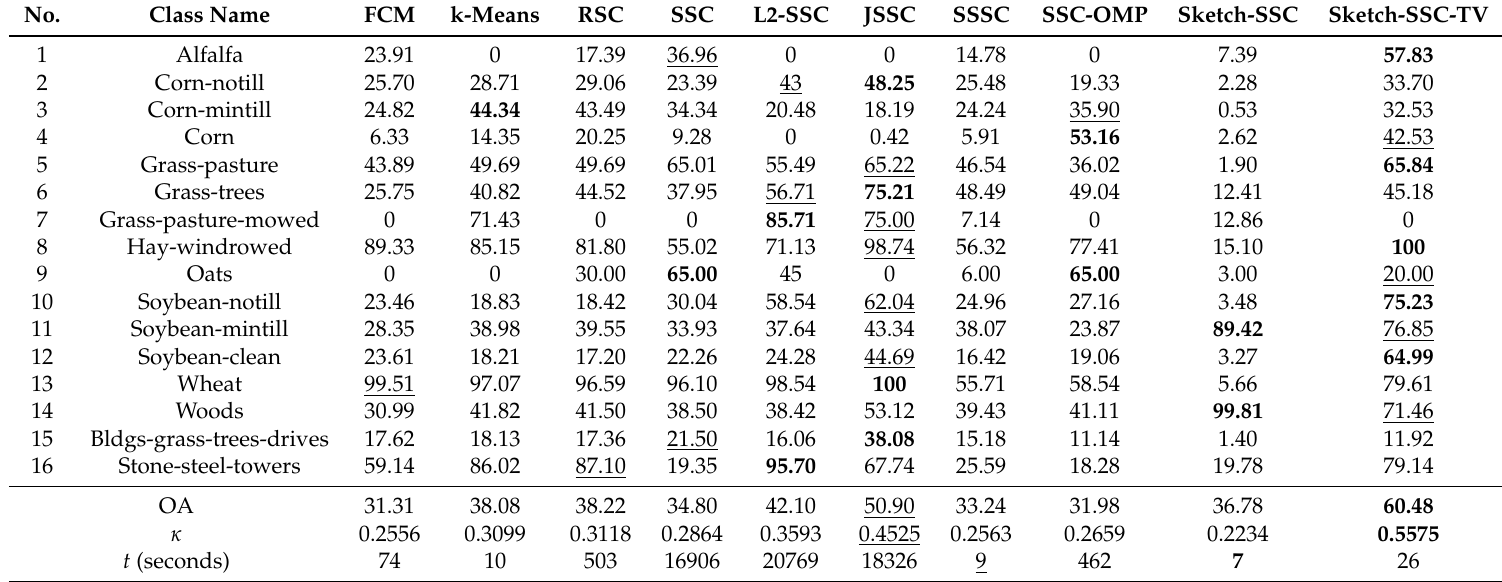
Table 3. Clustering accuracy for Indian Pines